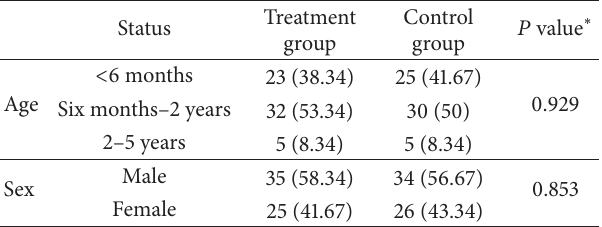
Table 1: Frequency distribution of the study population by age and sex ↑